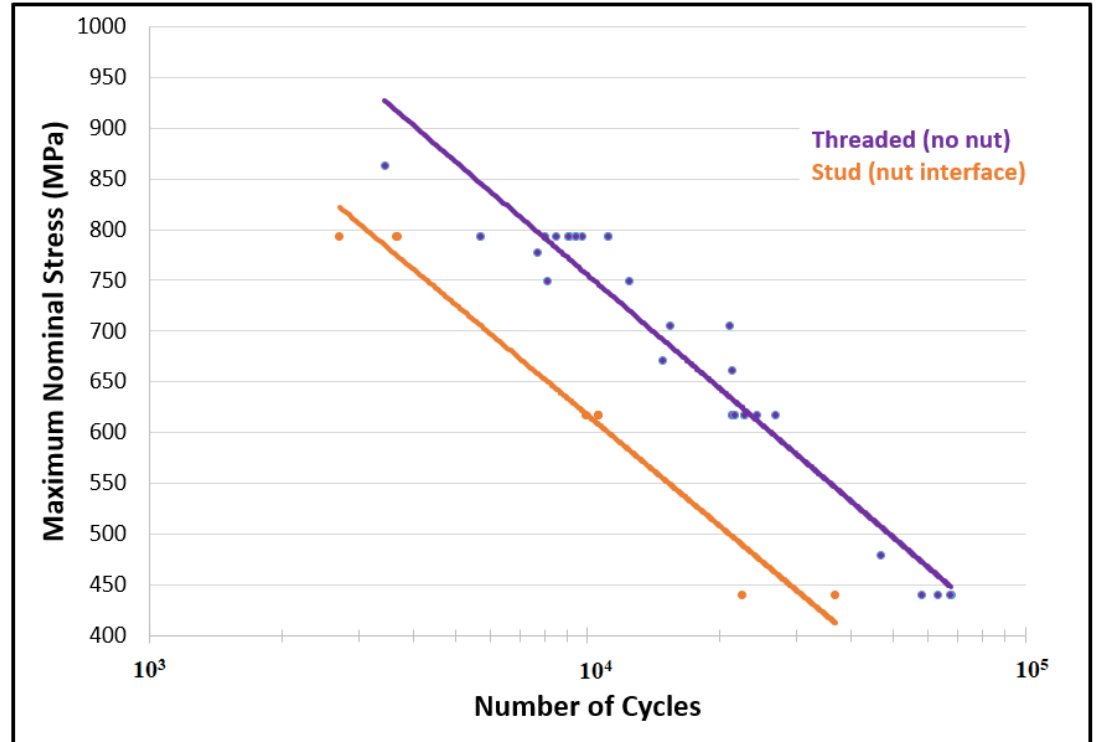
Figure 9. Fatigue life comparison (with and without nut